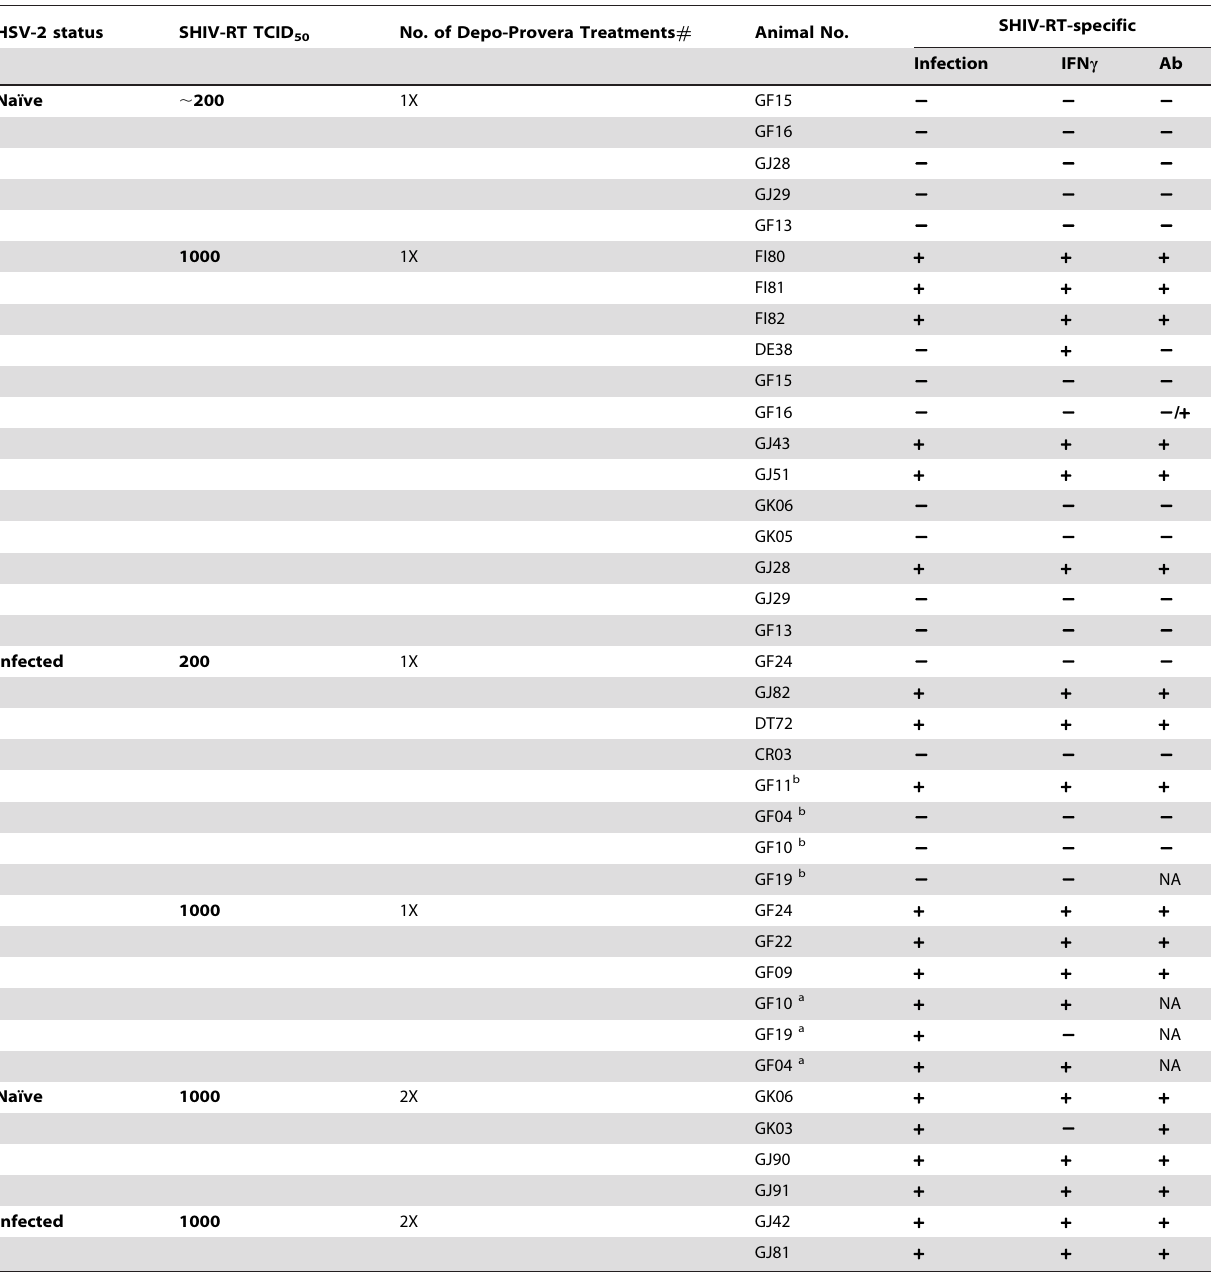
Table 1. HSV-2 exposure increases SHIV-RT infection